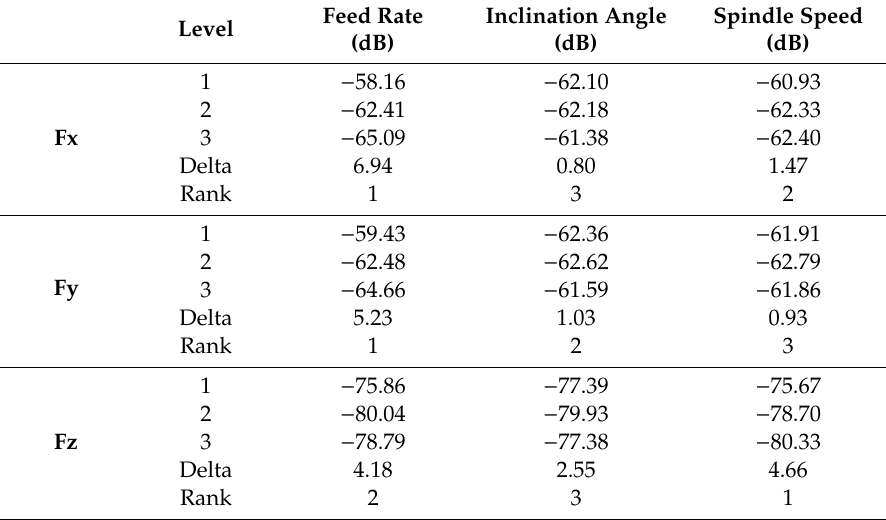
Table 7. Response table for mean S / N ratios for Fx, Fy and